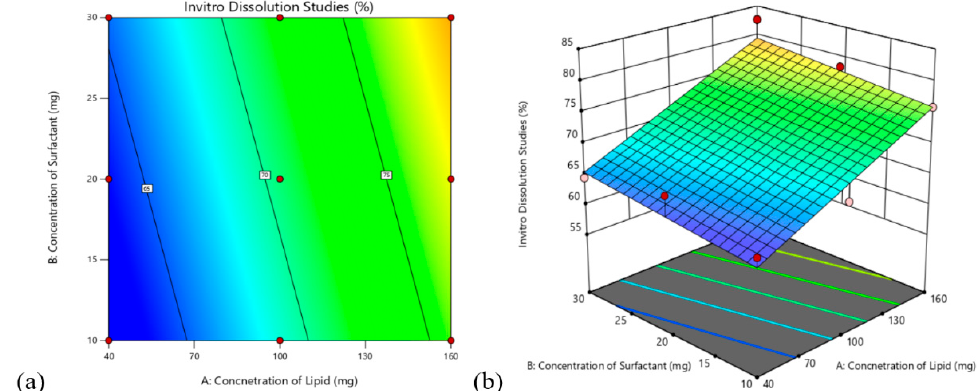
Figure 4. ( a ) 2D contour plot ( b ) 3D response showing the effect of independent variables on response Y2.